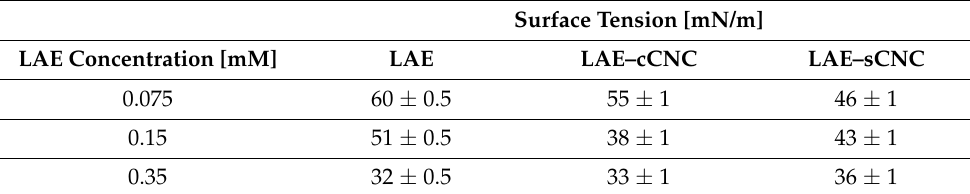
Table 1. The surface tension of analytical standard, pure and nanoparticle-dispersed ethyl lauroyl arginate. Contents of CNCs, 0.3